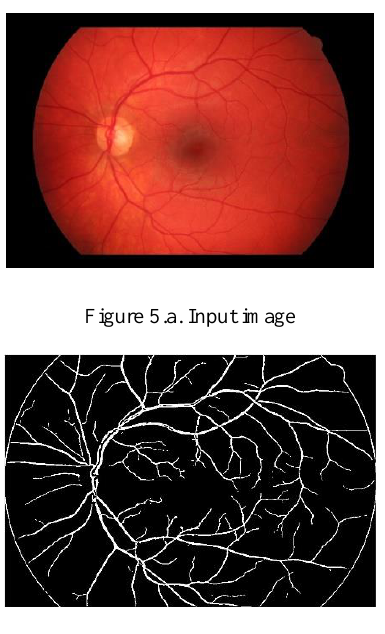
Figure 5.b. Output